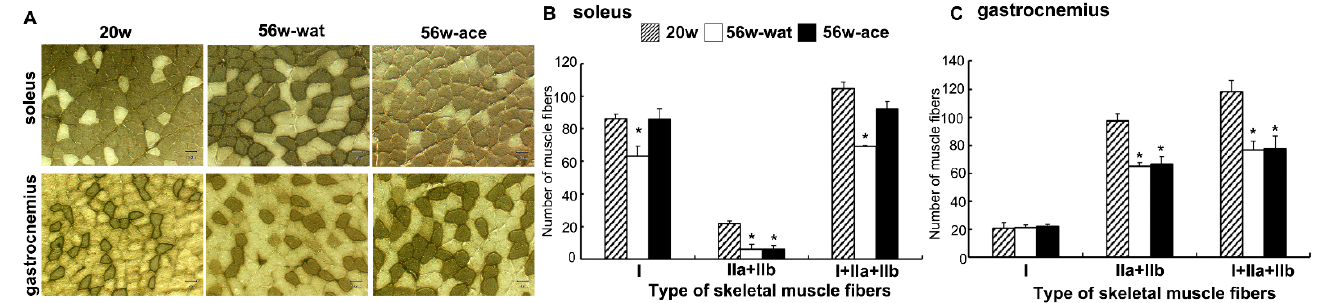
Figure 2. Light micrographs of the soleus and gastrocnemius muscles of rats at 20 and 56 weeks of age stained for ATPase ( A ). Number of fibers in the soleus ( B ) and gastrocnemius muscles ( C ). 20w: SD rats at 20 weeks of age; 56w-wat: SD rats at 56 weeks of age in the water group, 56w-ace: SD rats at 56 weeks of age in the acetic acid group. Fiber number was counted in a 0.45 mm 2 area. Scale bar: 50 μm. Values shown represent means ± SE for 4 – 5 rats. Results were analyzed with one-way ANOVA followed by the Tukey–Kramer post hoc test for multiple comparisons. * p < 0.05, statistically significant versus value obtained at 20 weeks of age.